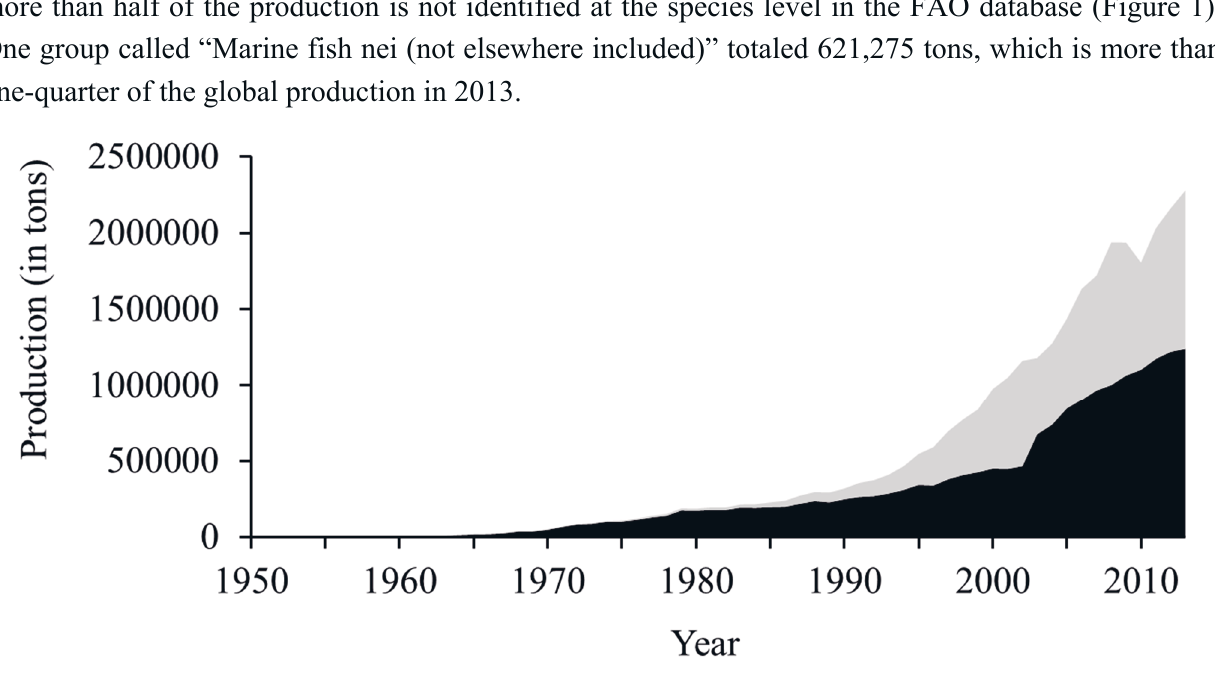
Figure 1. Evolution of global aquaculture production of marine fish species. Group of species, not identified at the species level ( upper part, in grey), identified at the species level ( lower part, in